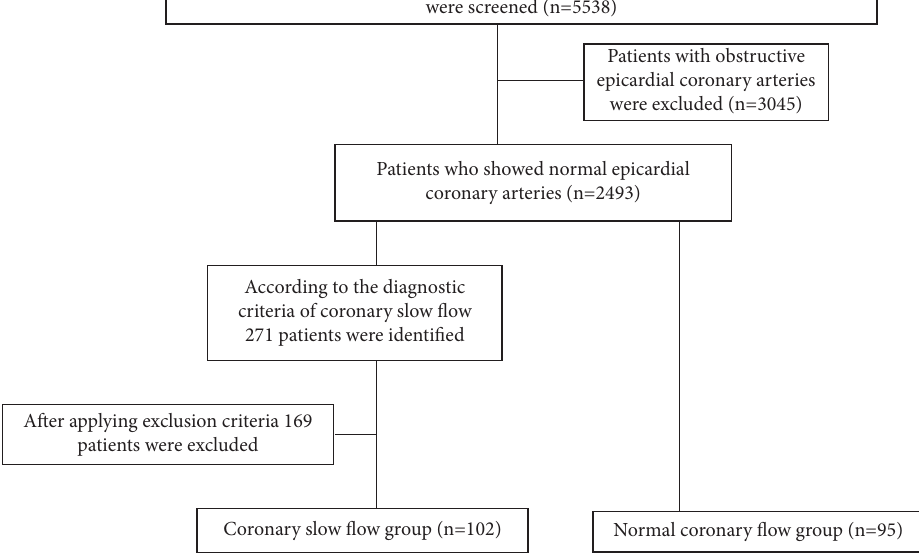
Figure 1: Te fowchart diagram showing study patients